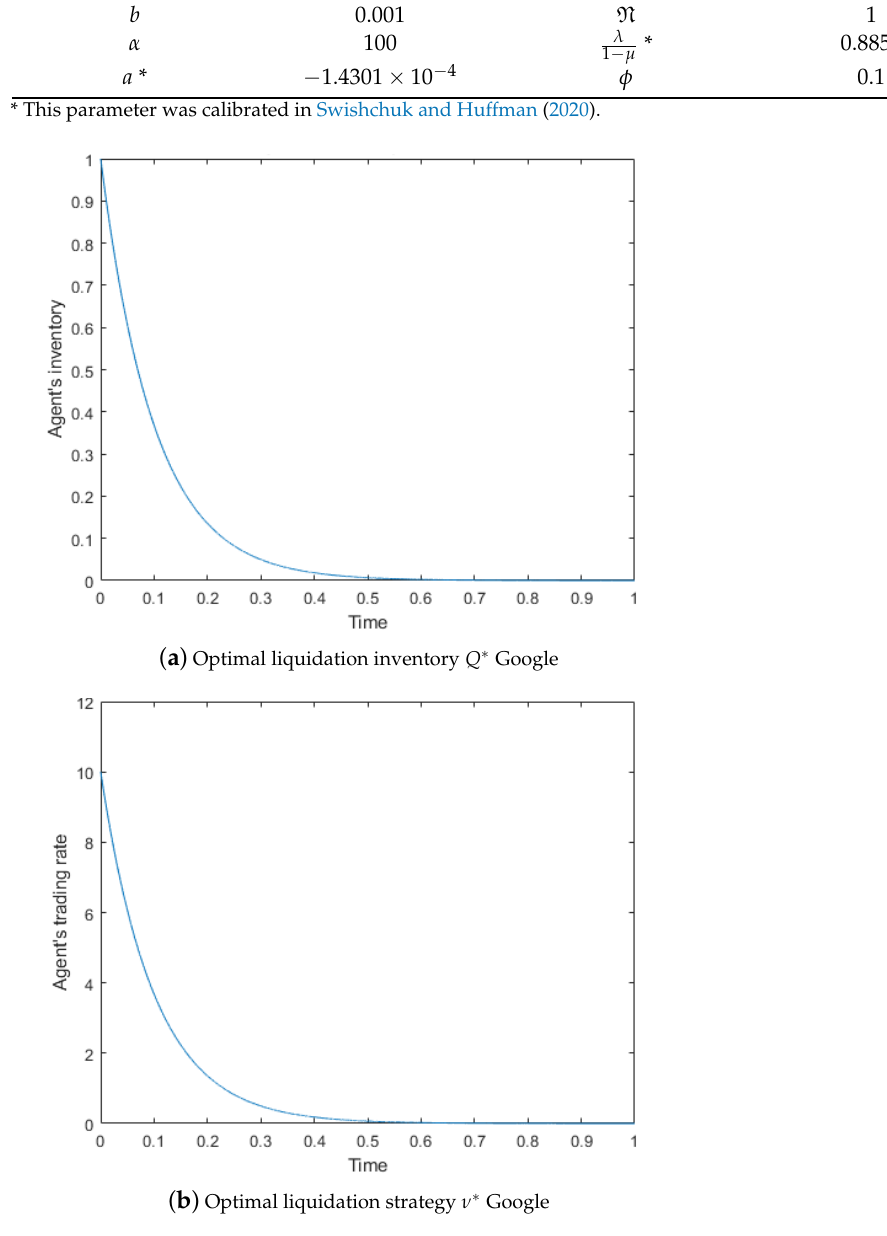
Figure 4. Optimal liquidation inventory and optimal liquidation strategy for Google stocks. ( a ) the inventory calculated using Equation (33), using the parameters in Table 4. ( b ) the optimal liquidation value calculated using Equation (34), using the parameters in Table